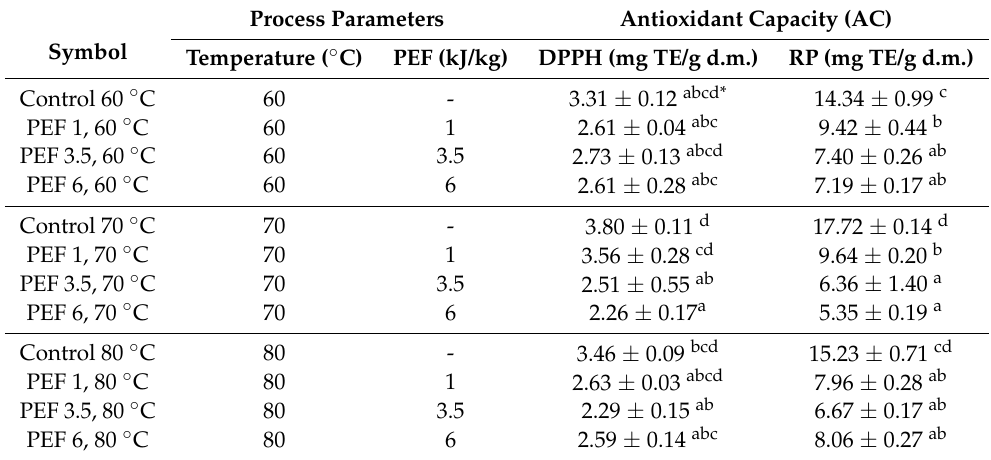
Table 2. Antioxidant capacity (with DPPH radicals and iron ion reducing power RP) of dried apple tissue obtained using different values for the parameters of pulsed electric field intensity (1, 3.5, and 6 kJ/kg) and hot air drying temperature (60, 70, and 80 ◦